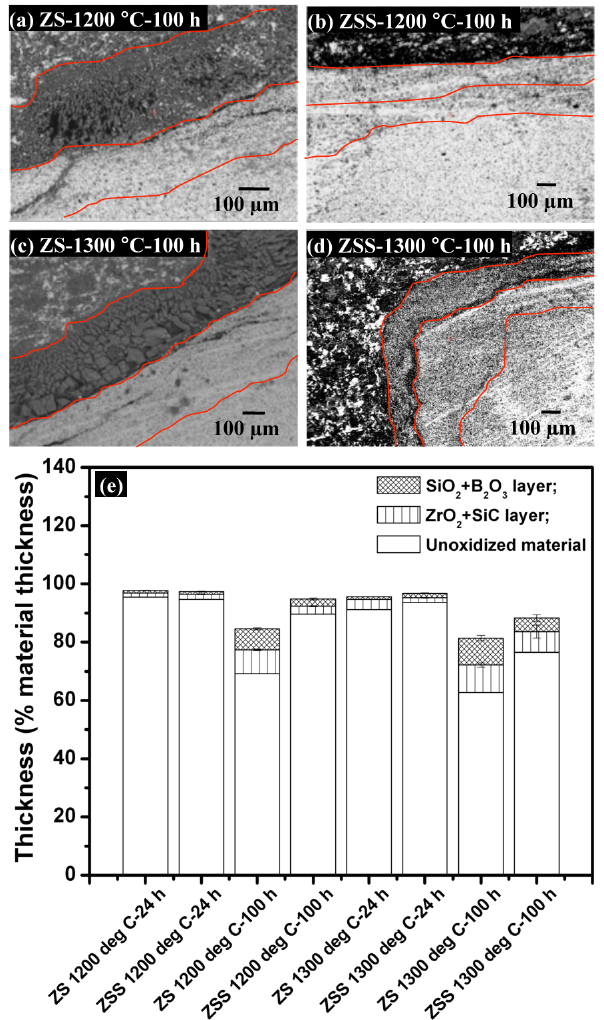
Figure 5. Cross ‐ sections of oxides scale formed by isothermal oxidation for 100 h in air: ( a ) ZS at 1200 °C; ( b ) ZSS at 1200 °C; ( c ) ZS at 1300 °C; and ( d ) ZSS at 1300 °C. The oxide scales exhibit a layer of SiO 2 ‐ B 2 O 3 followed by a layer of ZrO 2 ‐ SiC; ( e ) Thicknesses of unoxidized part of specimens, and the layers within the oxide scales formed on ZS and ZSS, subjected to exposure at 1200 or 1300 °C for 24 or 100 h.